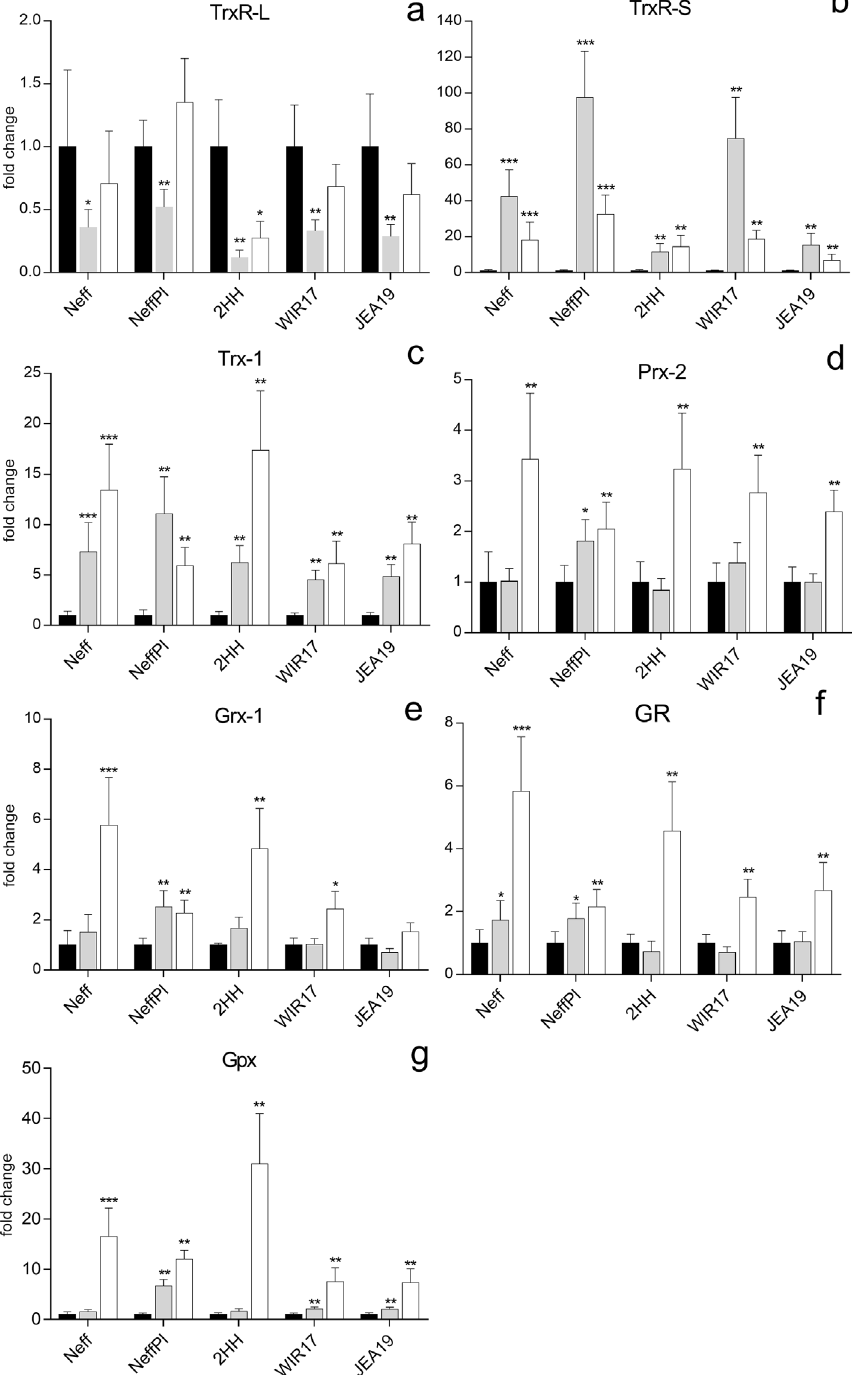
Figure 2. RNA expression of investigated target genes in strain Neff, strain Neff after plate culture (NeffPl), and three clinical Acanthamoeba isolates (2HH, WIR17, JEA19) after challenge with H 2 O 2 and diamide for two hours. (a) High-molecular weight thioredoxin reductase (TrxR-L), (b) low-molecular weight thioredoxin reductase (TrxR-S), (c) thioredoxin 1 (Trx-1), (d) peroxiredoxin 2 (Prx-2), (e) glutaredoxin 1 (Grx-1), (f) glutathione reductase (GR), (g) glutathione peroxidase (Gpx). Black bars: untreated control; grey bars: treated with 750 l M H 2 O 2 ; white bars: treated with 2 mM diamide. The y -axis indicates – fold increase of mRNA levels as compared to untreated controls. Error bars show the standard deviation of the mean (SEM). Values were obtained from at least two biological replicates in triplicate. * p < 0.05, ** p < 0.01, and *** p < 0.0001 according to statistical analysis (non-parametric Mann – Whitney U